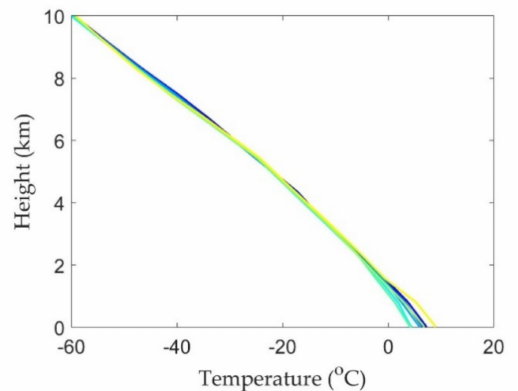
Figure 5. Profiles of temperature from 0200 to 1400 (UTC + 8) every two hours on 11 August 2019 at